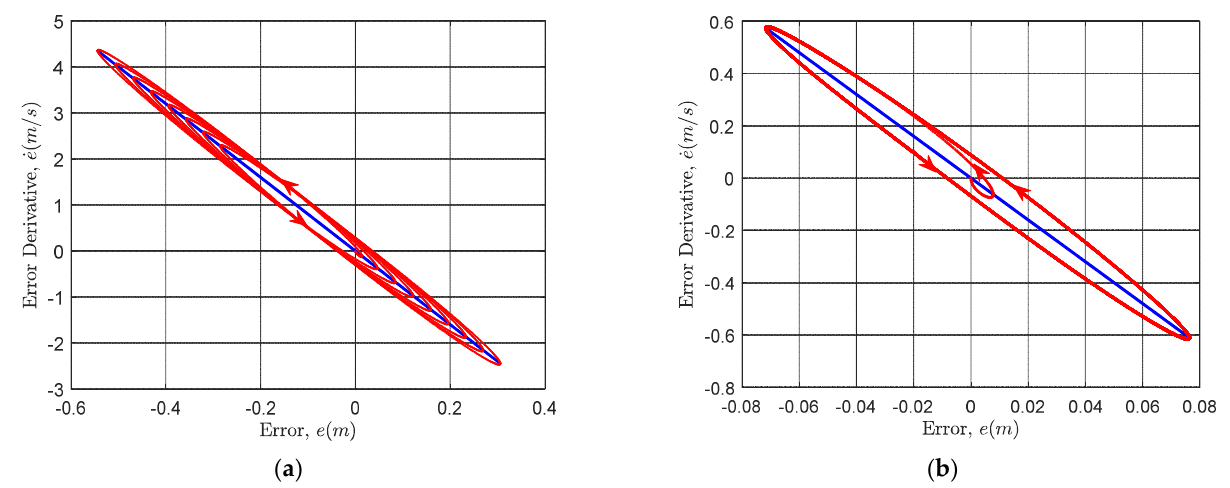
Figure 8. Phase−plane plot of sliding surface () with SMC coefficient of   = 10  on the left ( a ), and   = 100  Figure 8. Phase − plane plot of sliding surface s ( t ) with SMC coefficient of A c = 10 kN on the left ( a ), and A c = 100 MN on on the right ( b ). the right ( b ).